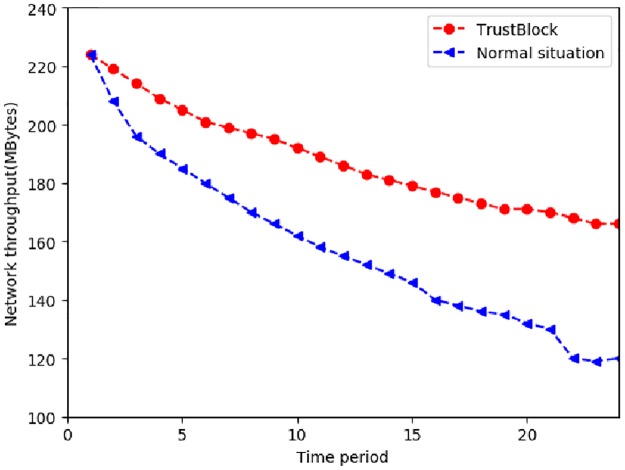
Trends in network throughput of untrusted nodes increasing.